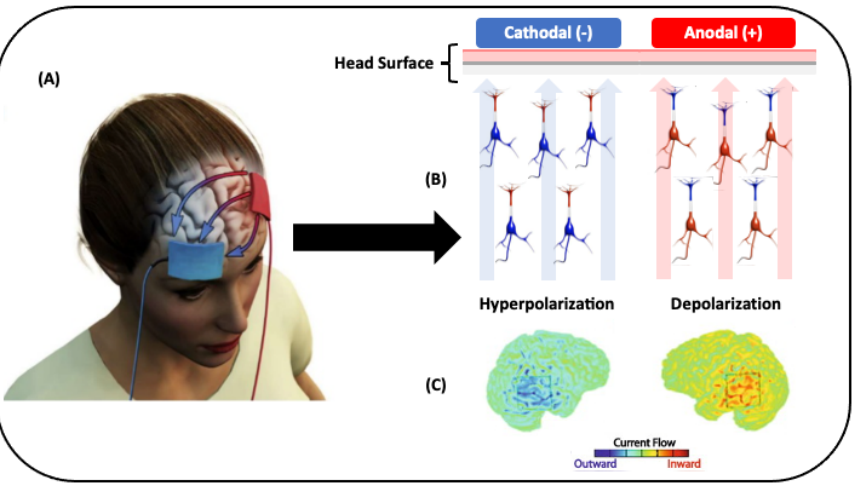
Figure 1. Mechanisms of action induced by transcranial direct current stimulation (tDCS). ( A ) Red electrode (anodal) delivering a weak electrical current towards the blue electrode (cathodal); ( B ) left side (cathodal electrode) shows the hyperpolarization of the neurons, provoking an inhibition in neuronal activity. Right side (anodal electrode) shows the inverse behavior, the depolarization of the neurons, generating an increase in neuronal activity. ( C ) Computational model showing in the left side a brain with reduced activity and, on the right side, a brain with increased activity.